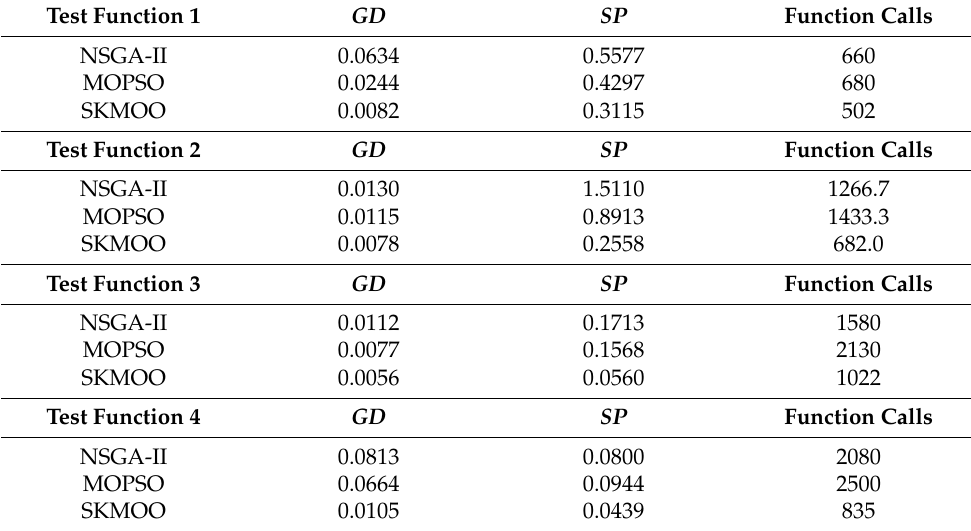
Table 1. The result of test functions.